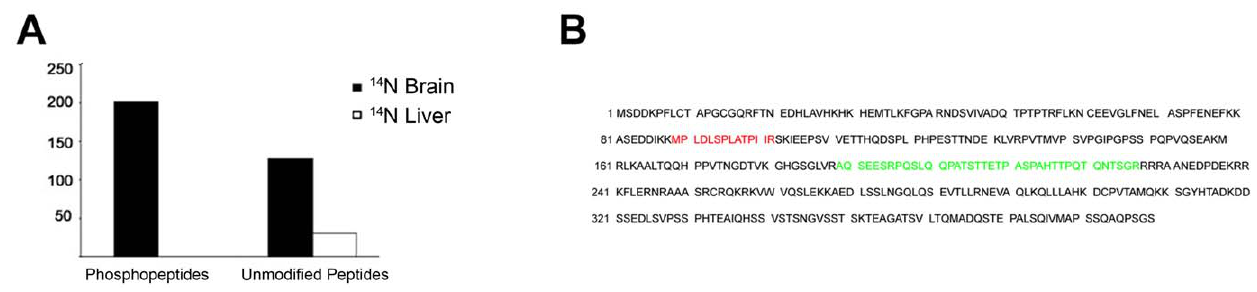
Figure 4. Singleton analysis. A, Phosphorylated and unmodified peptides determined to be singleton peptides. B, Three singleton phosphopeptides (green) were observed for ATF-2 with the sequence: AQS@EESRPQSLQQPATSTTETPASPAHTT@PQTQNTSGR. An identical phosphopeptide, was also assigned a N 14 /N 15 ratio of 42.5. A different phosphopeptide (red) of ATF-2, MPLDLS@PLATPIIR was quantified with a N 14 /N 15 ratio of 3.7 with Census.